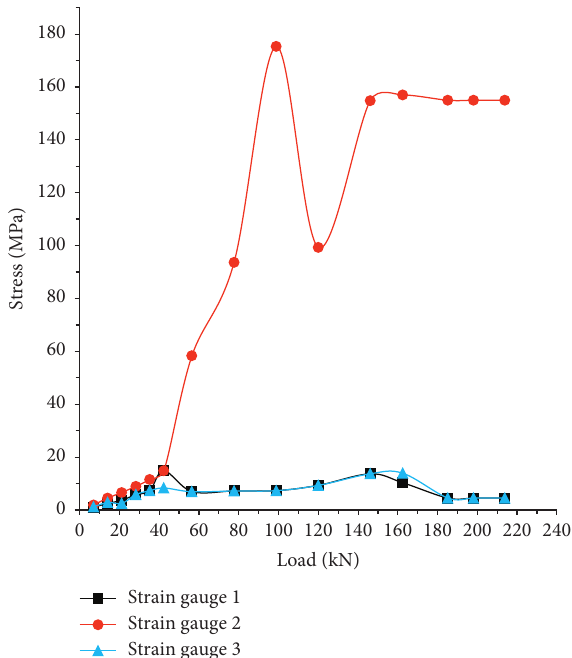
Figure 14: Stress/load curves at different measuring points on the SL-1 tensile LPCSHTHSC rebar.